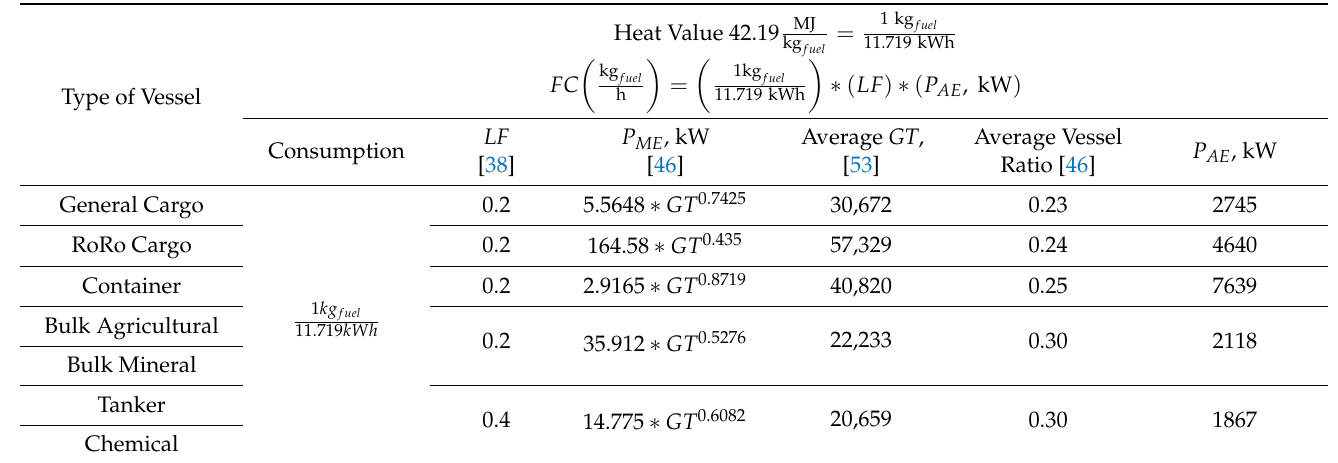
Table 7. Fuel consumption by type of ship considering the Heat Value method for Marine Diesel Oil in berthing